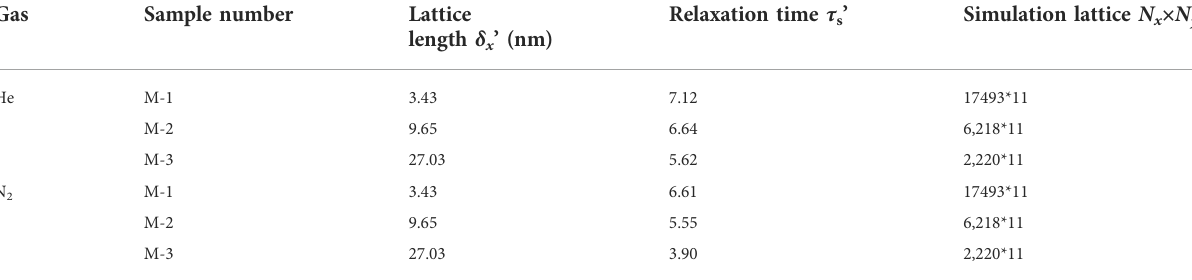
TABLE 3 Numerical simulation schemes.